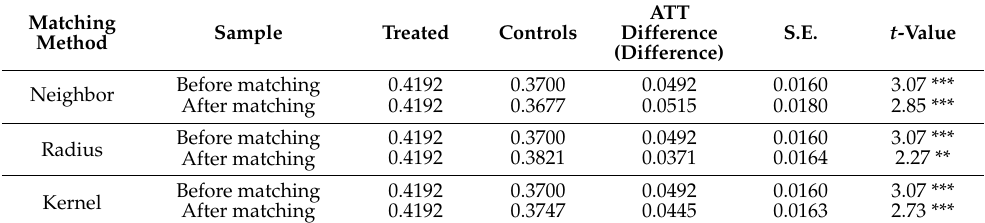
Table 10. Estimated results of average treatment effect of major diseases on loneliness of rural elderly. Matching